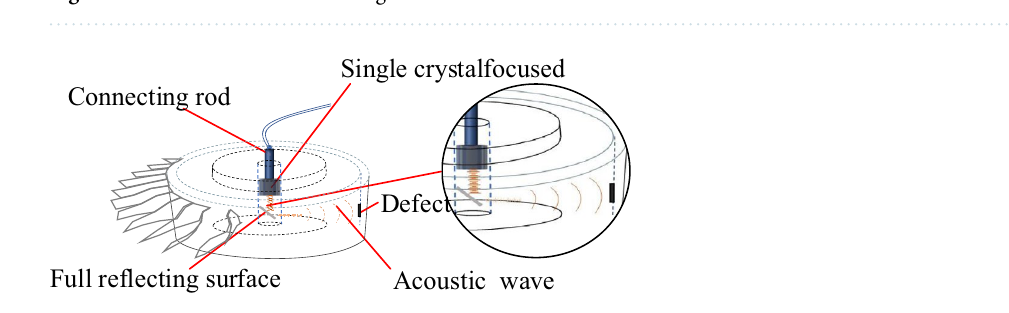
Figure 1. Turbine disk structure diagram.